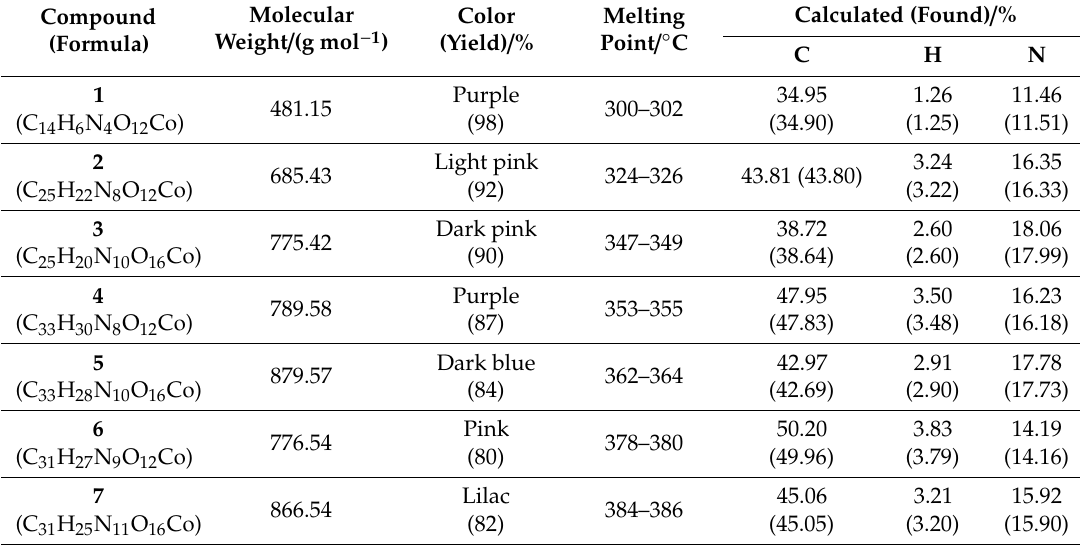
Table 1. Analytical and physical data of the